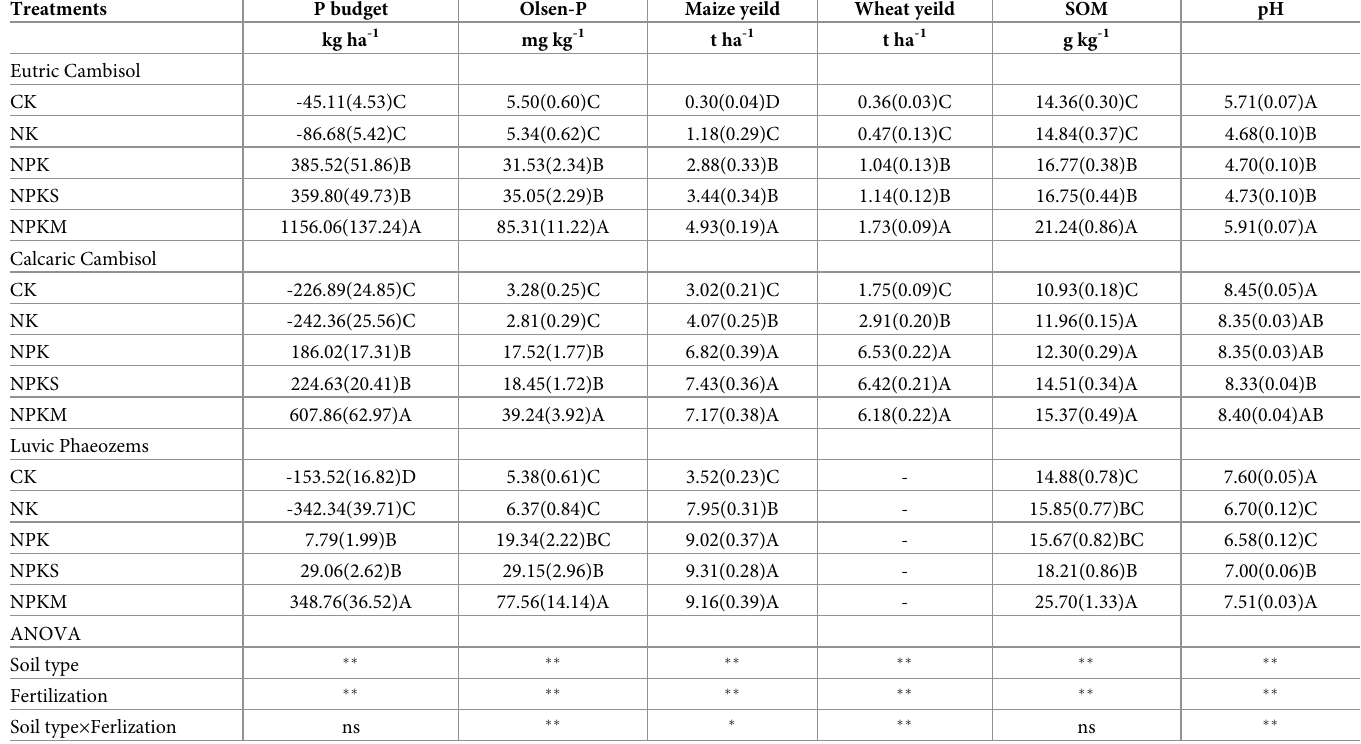
Table 3. Soil Olsen-P, P budget, crop yeil and soil properties (pH and SOM) under the three soil types and five treatments. ANOVA significance levels for the effects of soil type, fertilization, and soil type and fertilization interactions. Treatments